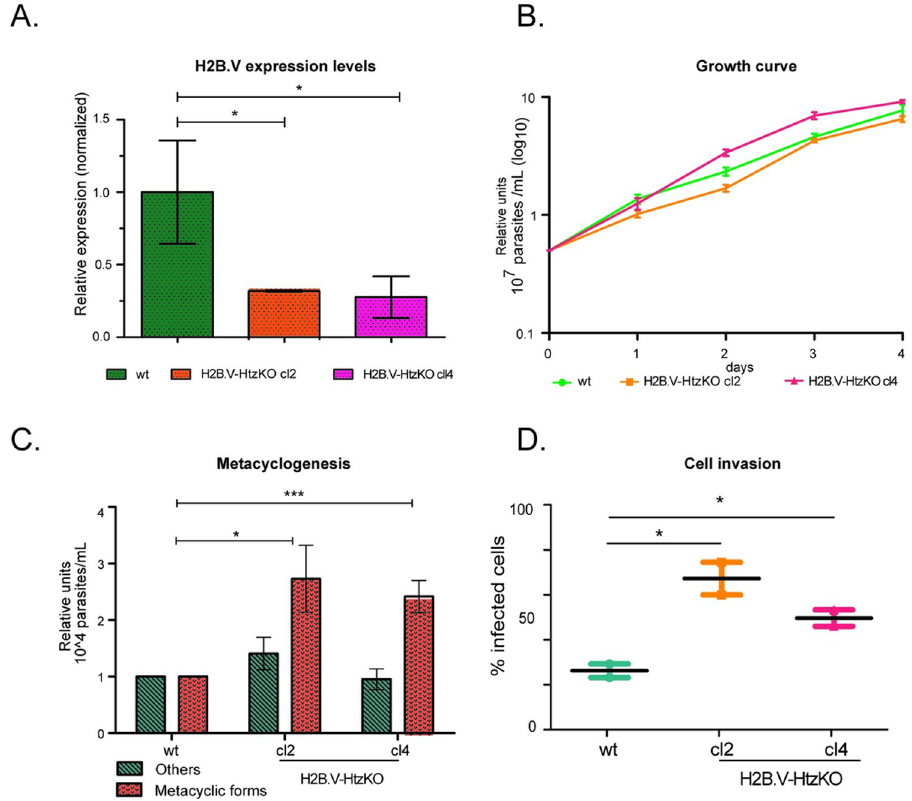
Fig 4. Phenotypic evaluation of H2B.V-HtzKO parasites. A. H2B.V relative expression levels were evaluated by qPCR in wild-type and H2B.V-HtzKO (cl 2 and 4) parasites. H2B.V transcript levels were assessed relative to GAPDH levels ( Δ CtH2BV– Δ CtGAPDH). One-way ANOVA: � p-value < 0.05. B. Mean growth curves (in log10) for wild-type and H2B.V-HtzKO (cl 2 and 4) parasites. C. Metacyclogenesis assay. The number of metacyclic trypomastigotes, epimastigotes and intermediate forms (herein, classified as other) were counted in 96-h supernatant upon nutritional stress as described in the Materials and Methods. Values were normalized to their respective numbers in wild-type cells. Experiments were performed in biological triplicates. Unpaired T-test: � p < 0.05 and ��� p < 0.01 with Bonferroni correction. D. H2B.V-HtzKO parasites are more infective. LLCMK2 cells were infected with TCTs (1:40; cells:parasite). Slides were fixed, and nuclei were labeled with DAPI. The number of infected cells was counted relative to the total cells after 1 h of infection by fluorescence microscopy. Unpaired t-test with Welch’s correction ��� p <